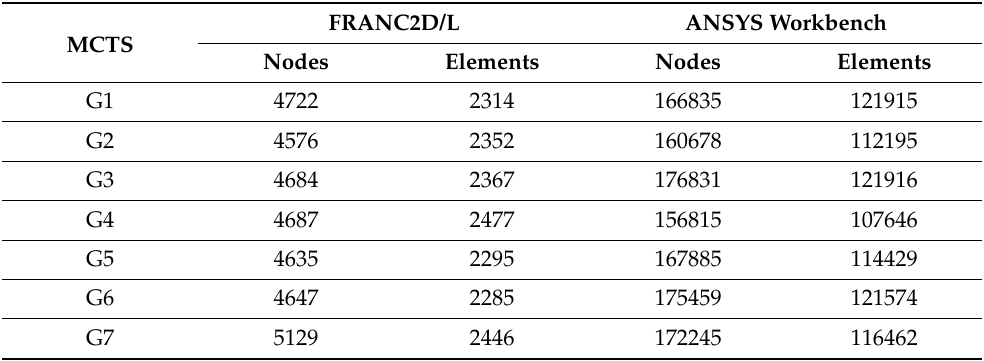
Table 2. Number of nodes and elements of the specimens in Franc2D/L and ANSYS. FRANC2D/L ANSYS Workbench MCTS Nodes Elements Nodes Elements G1 4722 2314 166835 121915 G2 4576 2352 160678 112195 G3 4684 2367 176831 121916 G4 4687 2477 175459 121574 172245